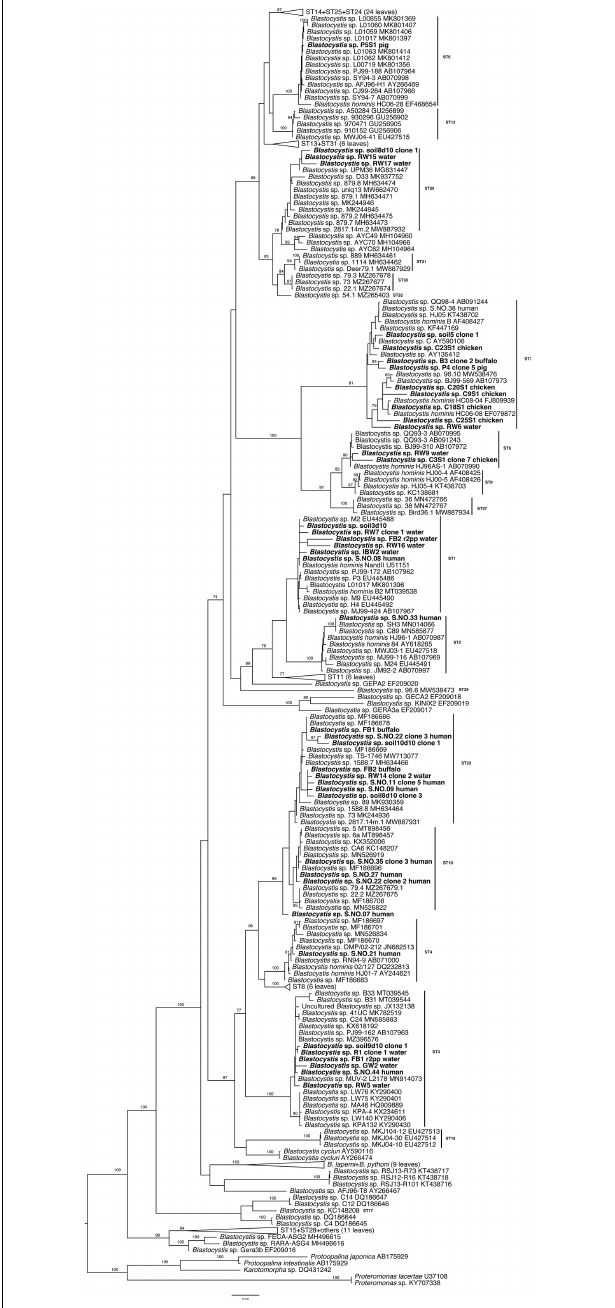
FIGURE 3 | Maximum likelihood phylogenetic tree inferred from 250 taxa and 1,497 sites of the SSU rRNA gene. The tree is artificially rooted to Proteromonas , Protoopalina, and Karotomorpha sequences. Newly generated sequences are in bold. Numerical values indicate bootstrap support. Only values above 70% are depicted.